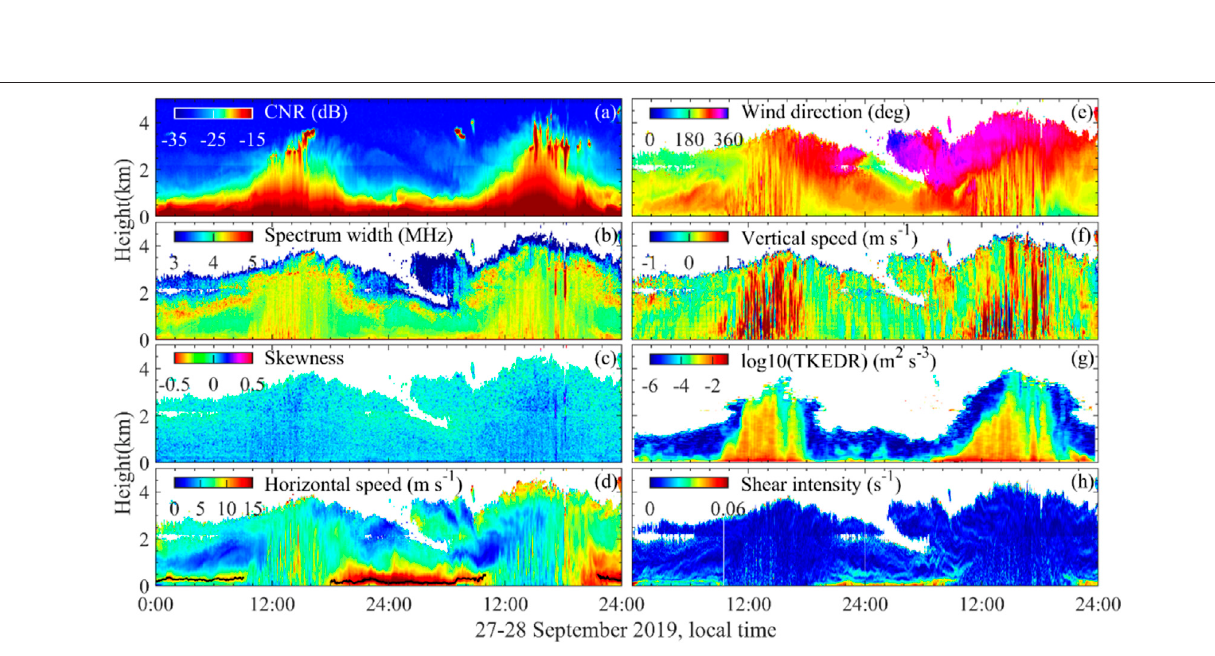
FIGURE 8 | Continuous C-DWL observations of low-level jets and turbulence during September 27 – 28, 2019. (A) CNR, (B) spectrum width, (C) skewness, (D) horizontal wind speed, (E) horizontal wind direction, (F) vertical wind speed, (G) log10 (TKEDR), and (H) shear intensity. The negative vertical wind speed indicates upward wind. The black lines on (D) and (E) show low-level jet